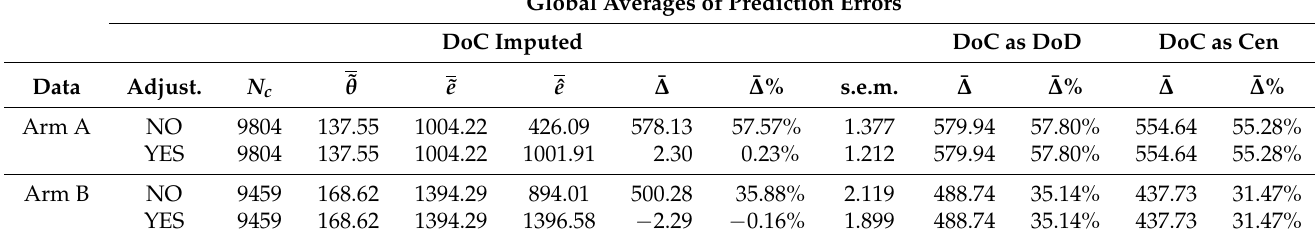
Table 6. Effect of CoDMI adjustment for censoring when all COVID-19 endpoints are simulated